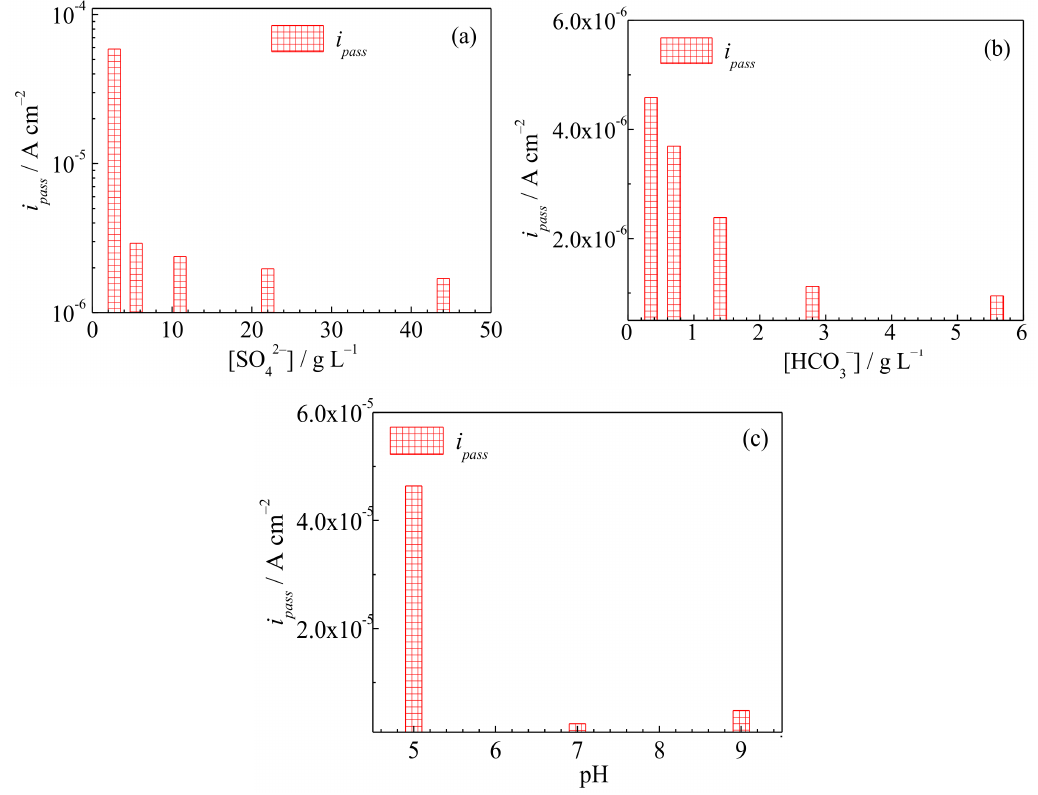
Figure 7. Potentiodynamic polarization curves of the 201 stainless steel in the underground water with different SO 42 − and HCO 3 − concentration, as well as different pH values, ( a ) A1–A5 solutions with different concentration of SO 42 − , ( b ) B1–B5 solutions with different concentration of HCO 3 − , and ( c ) C1–C3 solutions with different pH values.